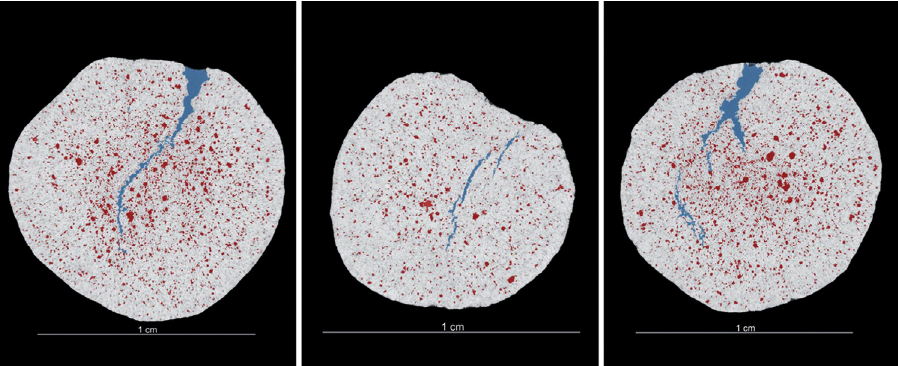
Figure 2. Applying a DL network in three different layers of the reference specimen; pores are indicated in red, cracks in blue, and solids in gray adapted with permission from Ref. [50]. 2023, Jório Coelho